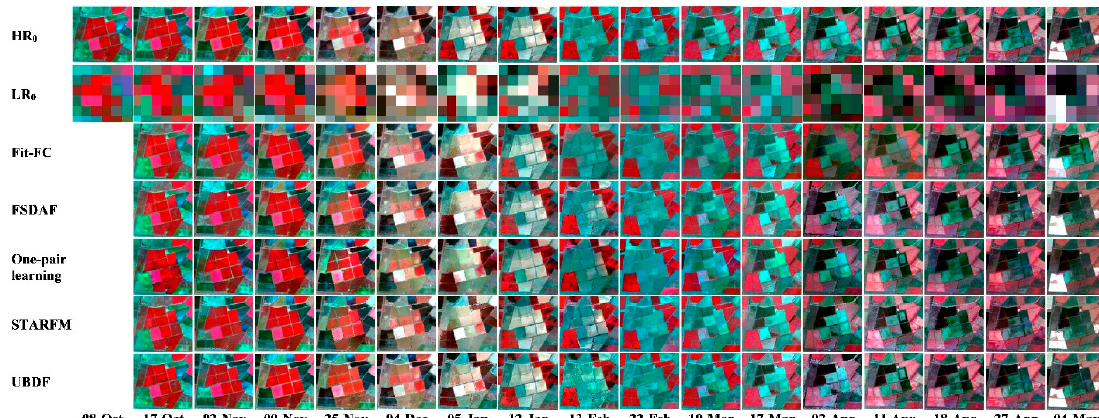
Figure A2. Observed Landsat data and simulated Landsat-like images with the fusion method indicated above for the subregion B of Coleambally in Figure 2. All images are displayed in chronological order from 2001 to 2002 (NIR, red and green as RGB).